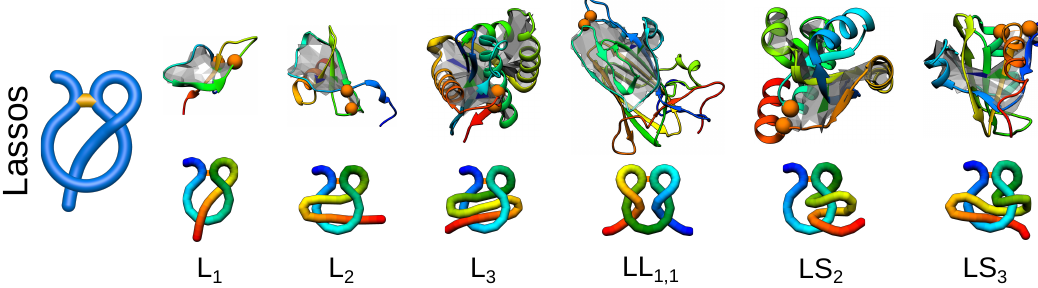
Figure 5. Different types of lassos identified in proteins to date. For each link type, an exemplary structure along with a scheme of its topology is presented. The PDB IDs of the structures (left to right): 1ews, 5uiw, 2ehg, 4a3x, 1zd0,